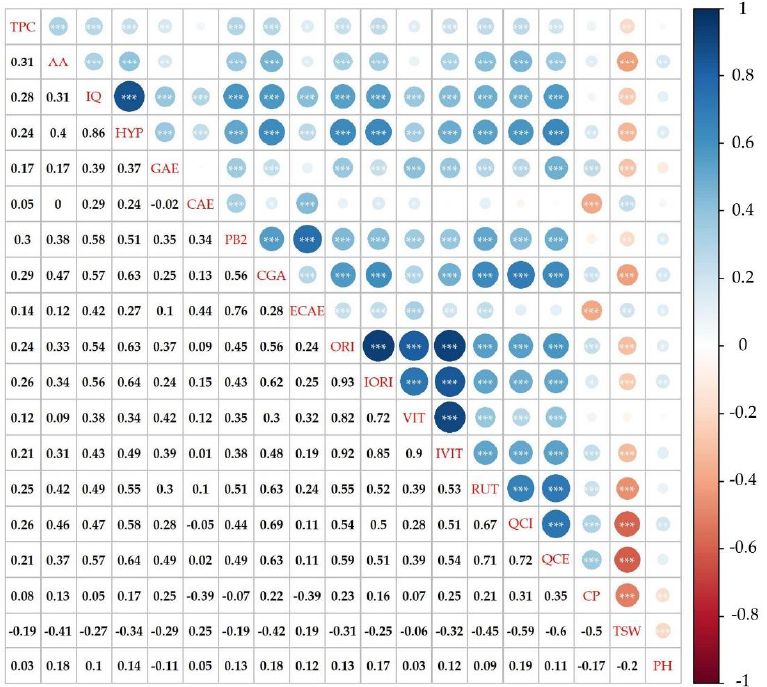
Figure 4. Spearman’s correlation between evaluated descriptors for the collection of selected buck- wheat genotypes. The colours of the circles above the diagonal indicate whether the correlation between the pair of descriptors was negative (red)/positive (blue), while their magnitude is propor- tional to the Spearman ’s ρ indicated below the diagonal. Significant correlatio ns are represented by * ( p < 0.05), ** ( p < 0.01) and *** ( p < 0.001), respectively. AA of all 136 buckwheat accessions determined with the stable radical 2,2-diphenyl- 1-picrylhydrazyl (DPPH) is shown in Tables S2 and S3. On average, AA was higher in